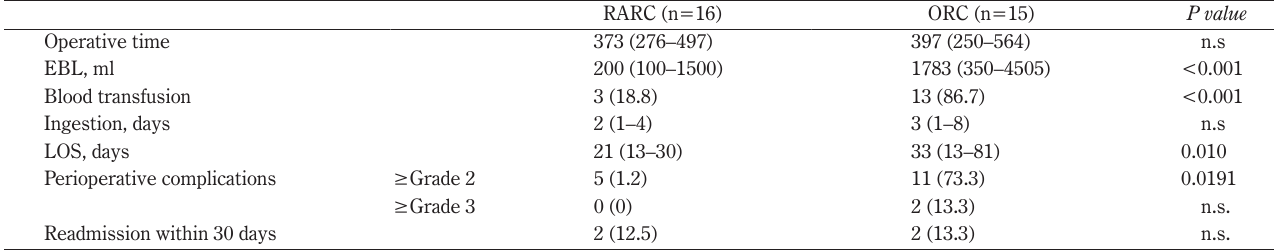
Table 4 Operative and postoperative